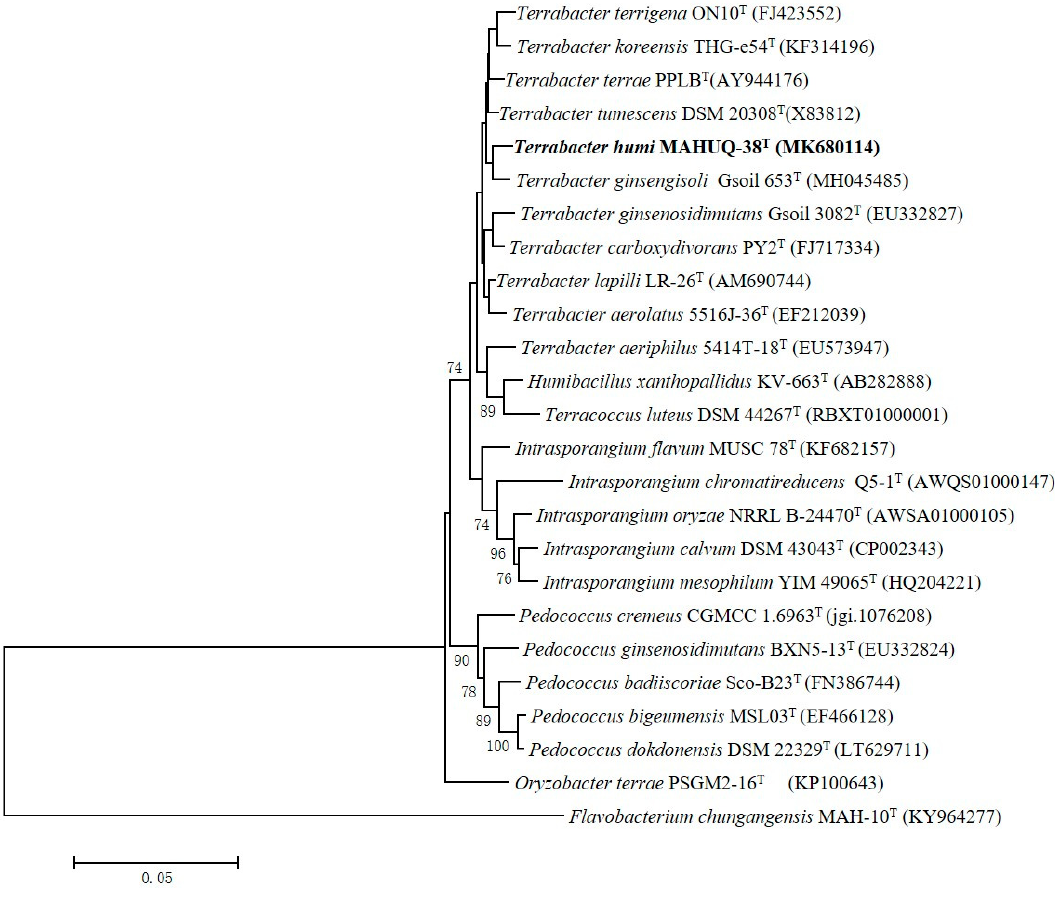
Figure 2. Neighbor-joining (NJ) tree based on 16S rRNA gene sequence analysis showing phylogenetic relationships of strain MAHUQ-38 T and members of genus Terrabacter . Bootstrap values more than 70% based on 1000 replications are shown at branching points. Scale bar, 0.05 substitutions per nucleotide position.